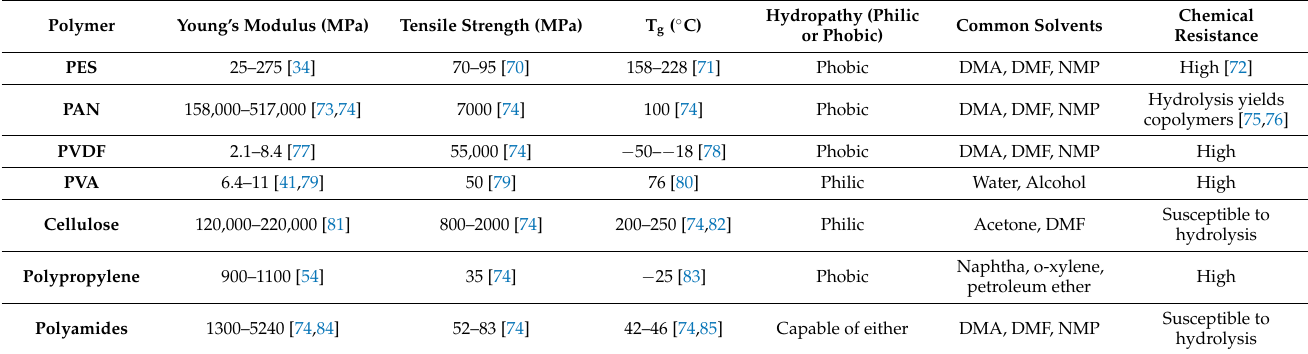
Table 1. Physical properties of common polymers used in liquid filtration